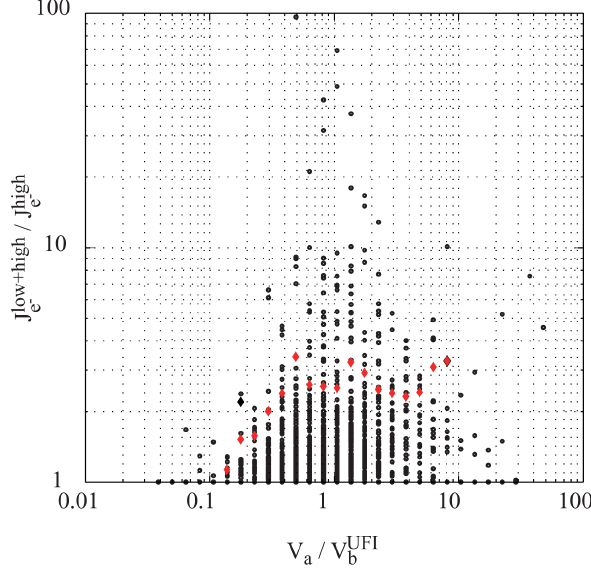
+ high to J high and the e − e − b